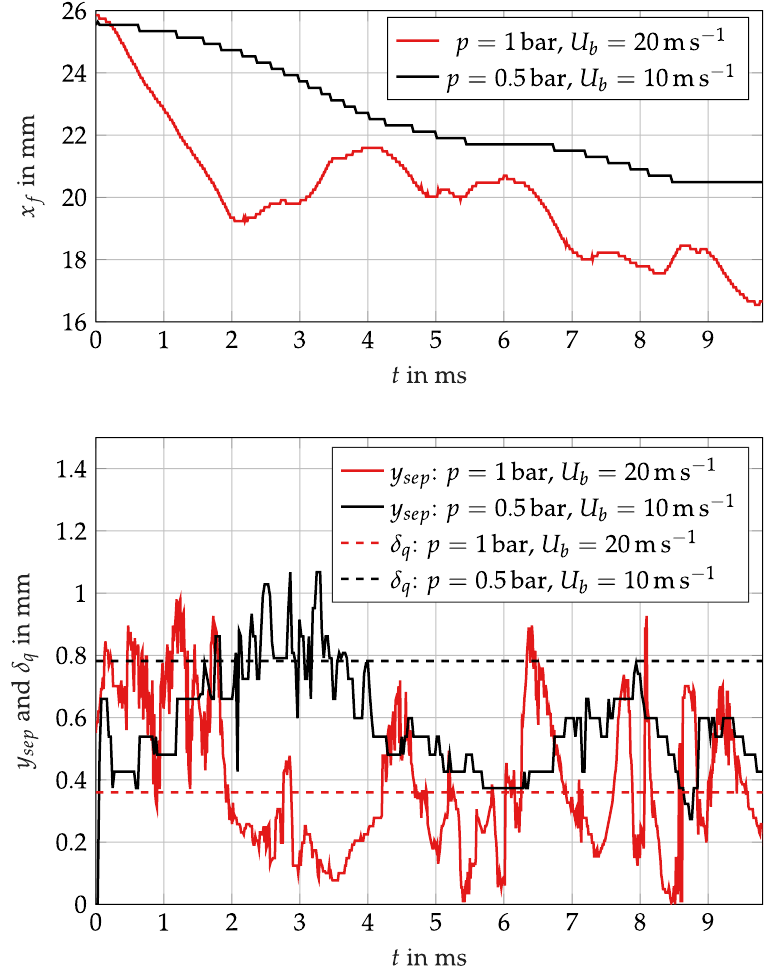
Figure 13. Flame front position, separation zone size and quenching distance during flame flashback. Flame front position x f is given by the foremost cell with c >